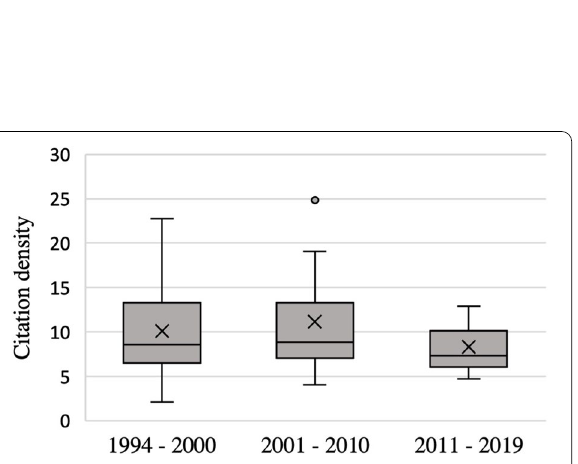
Fig. 6 Citation density of all articles published according to the last three decades